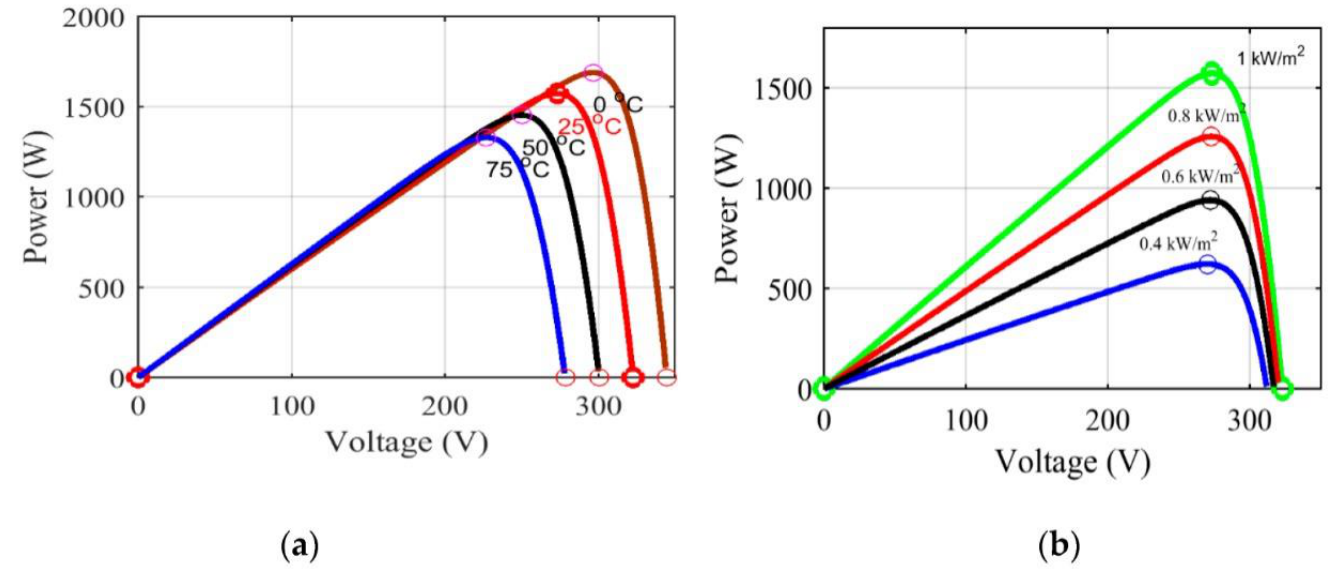
Fig. 1 . Characteristic curves of a photovoltaic cell for changing temperature and illumination